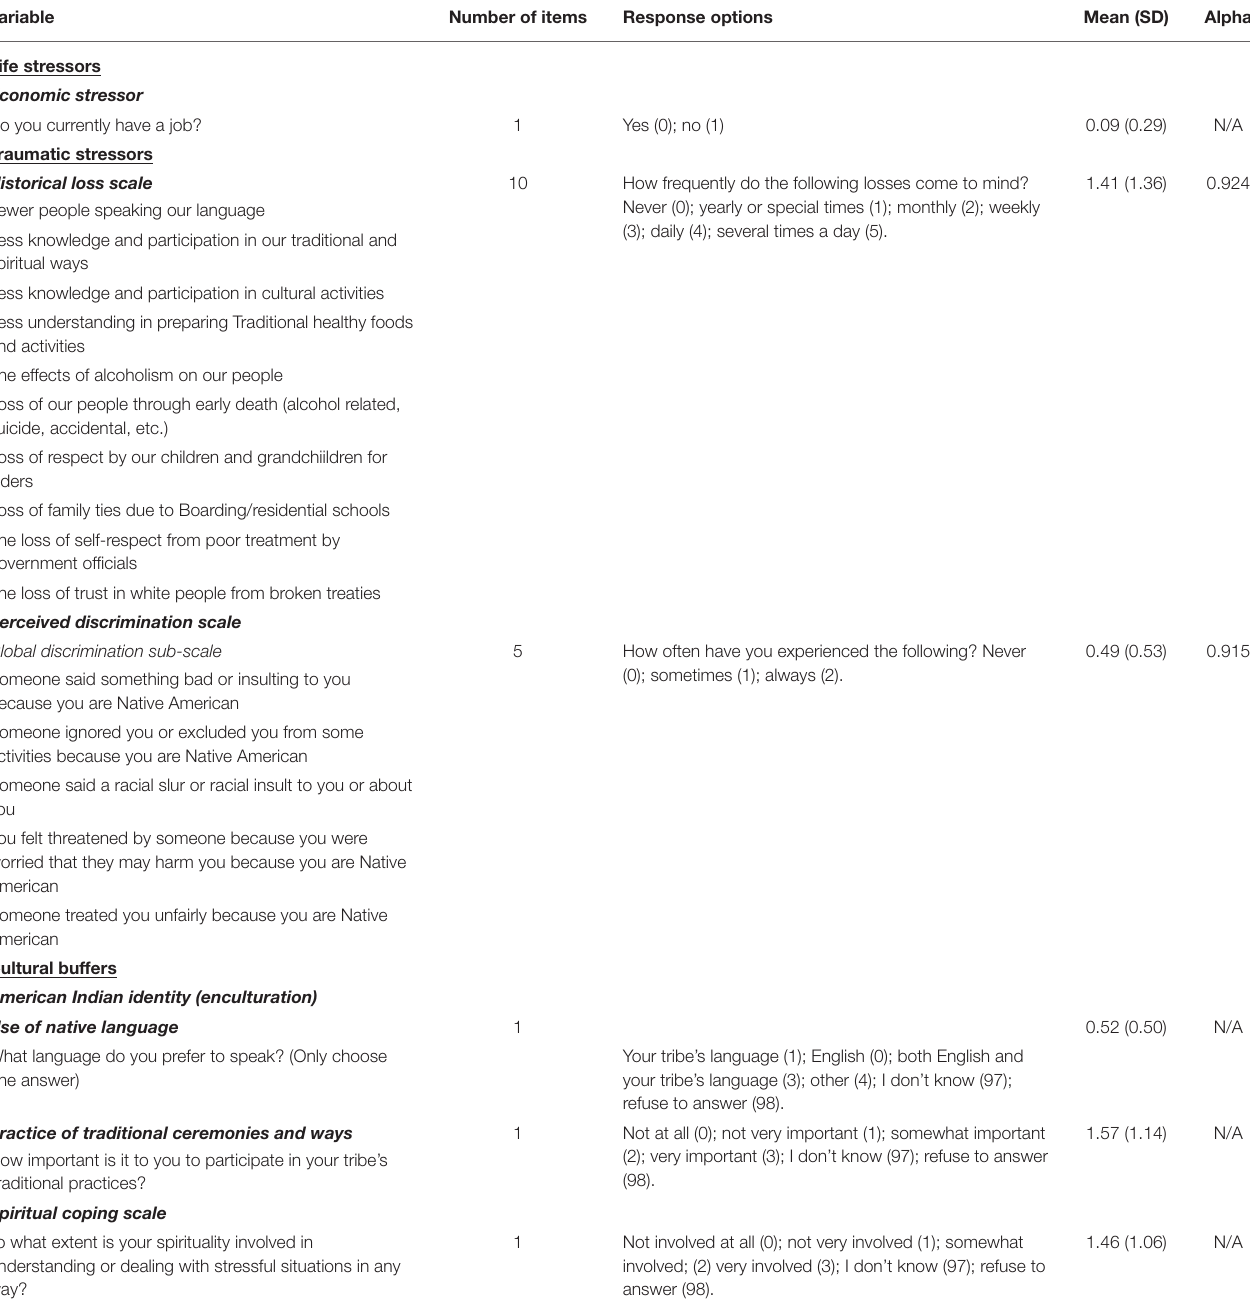
TABLE 1 | Measures of stressors and cultural buffers operationalized for indigenist stress coping (ISC) model among American Indians with binge substance use in a rural community, N = 254.